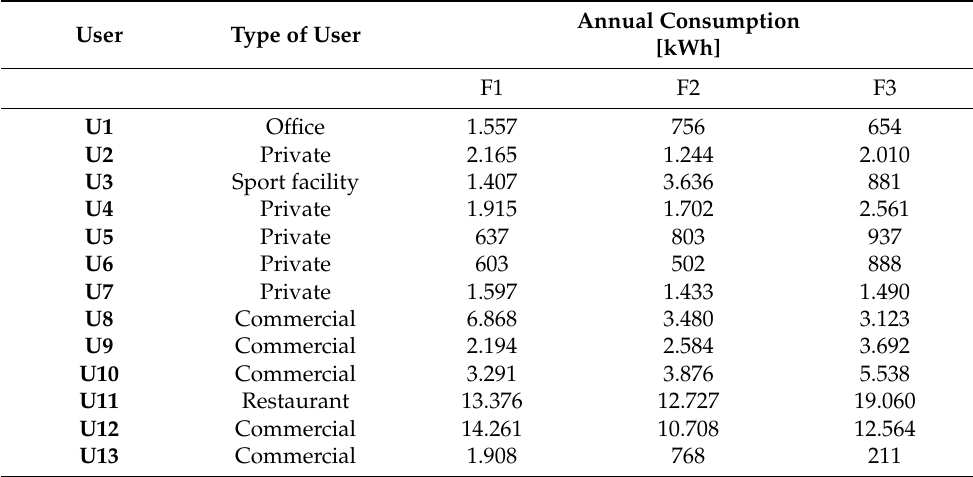
Table 3. Annual electricity